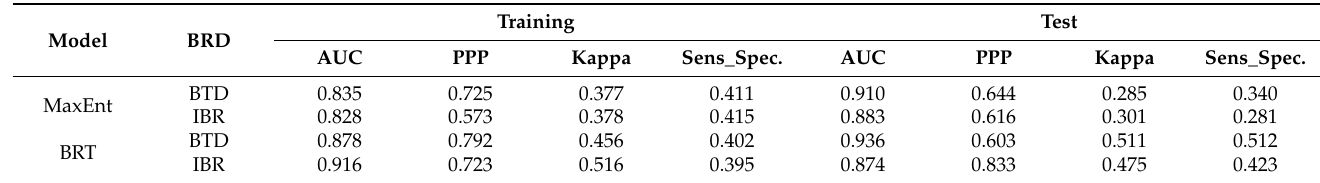
Table 2. Assessment of model accuracy for predicting the global area under the curve (AUC) of a receiver operator curve (AUC), positive predictive power (PPP), Cohen’s kappa and the thresh- old at which the sum of the sensitivity (true positive rate) and specificity (true negative rate) is highest